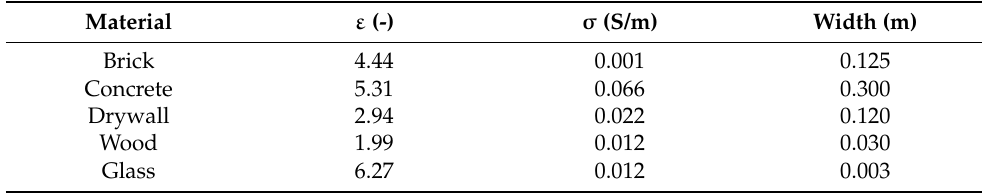
Table 1. Electromagnetic parameters of materials used during modeling. Parameters available for 2.4 GHz signal frequency